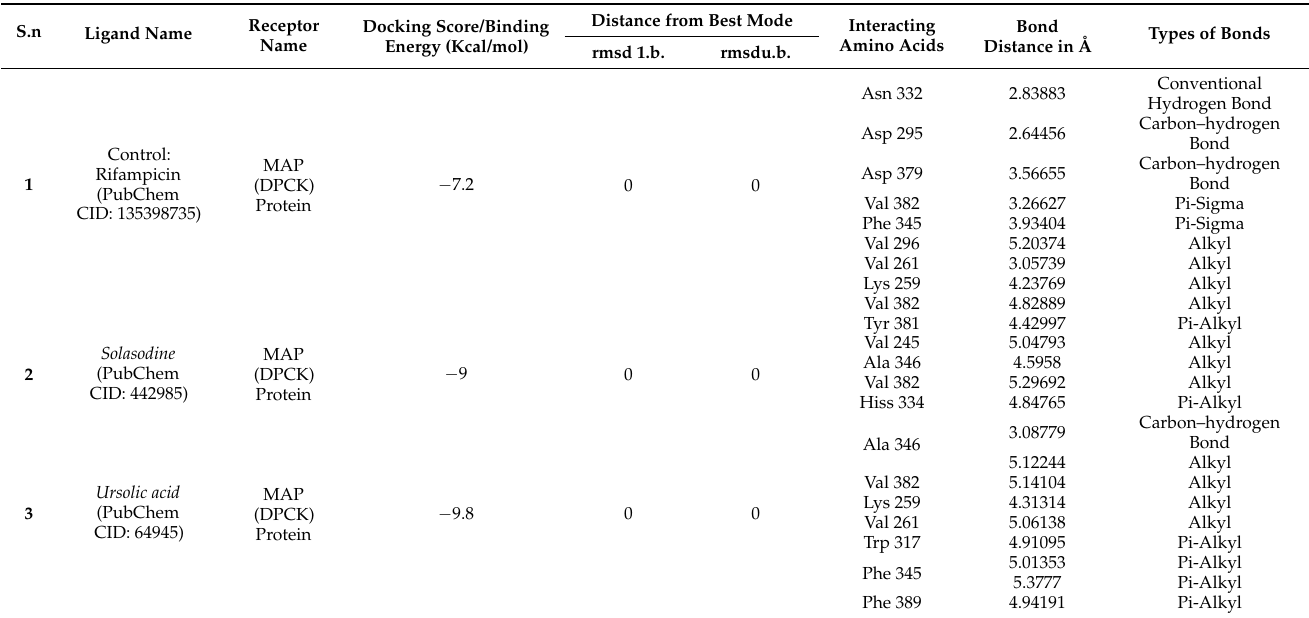
Table 2. Molecular docking between Ursolic acid and Solasodine with receptor in comparison to Rifampicin